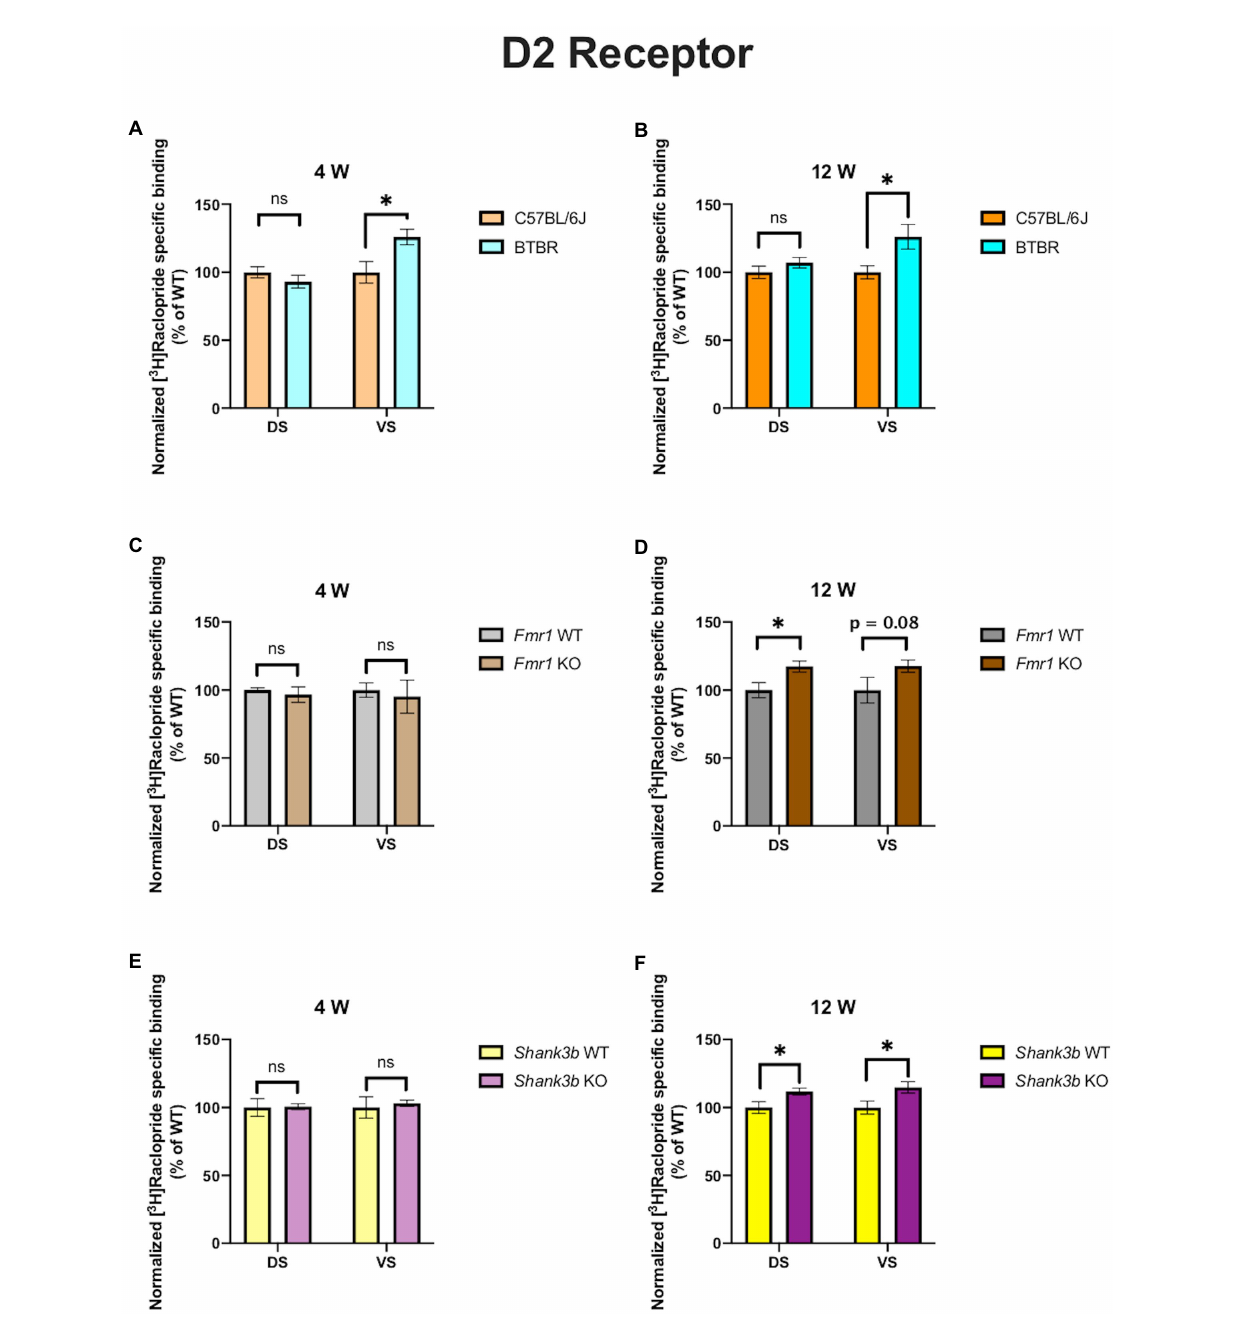
FIGURE 3 Bar charts representing mean and SEM of the receptor density for D2 receptors. DS: C57BL6/J ( n = 9), BTBR ( n = 8) and VS : C57BL6/J ( n = 9), BTBR ( n = 6) at 4 weeks of age (A) ; DS: C57BL6/J ( n = 10), BTBR ( n = 9) and VS : C57BL6/J ( n = 10), BTBR ( n = 7) at 12 weeks of age (B) ; DS: Fmr1 WT ( n = 8), Fmr1 KO mice ( n = 8) and VS : Fmr1 WT ( n = 8) and Fmr1 KO mice ( n = 8) at 4 weeks of age (C) ; DS: Fmr1 WT ( n = 5), Fmr1 KO mice ( n = 8) and VS : Fmr1 WT ( n = 5) and Fmr1 KO mice ( n = 8) at 12 weeks of age (D) ; DS: Shank 3b WT ( n = 6), Shank3b KO mice ( n = 6) and VS : Shank 3b WT ( n = 6), Shank3b KO mice ( n = 6) at 4 weeks of age (E) ; DS: Shank 3b WT ( n = 12), Shank3b KO mice ( n = 12) and VS : Shank 3b WT ( n = 12) and Shank3b KO mice ( n = 11) at 12 weeks of age (F) . Significant differences are indicated with an asterisk (* p < 0.05). Changes are represented as percentage of the mean of C57BL6/J, Fmr1 WT, Shank3b WT mice,